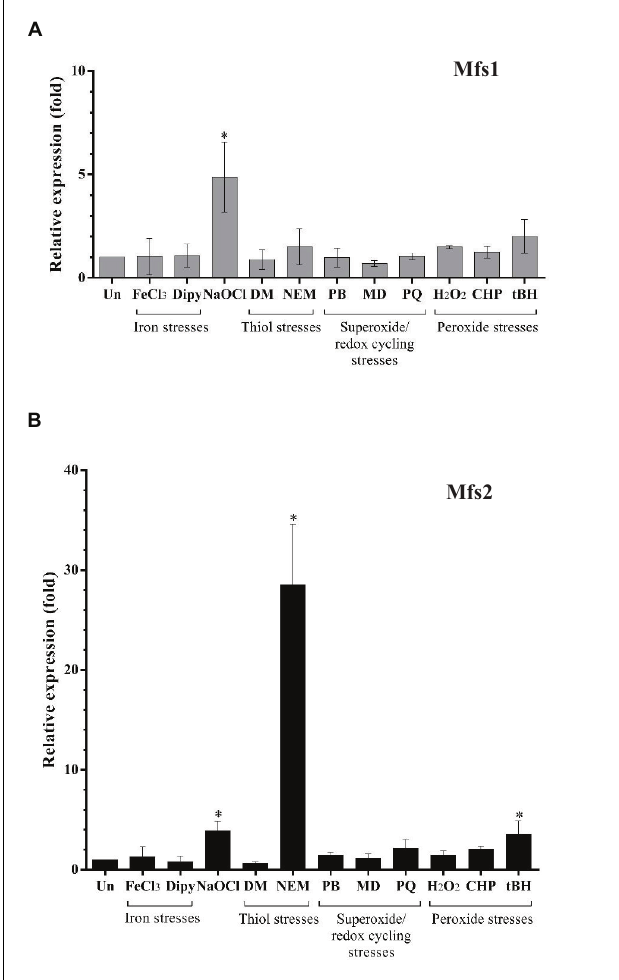
FIGURE 1 | Relative expression of (A) mfs1 and (B) mfs2 in response to stresses in PAO1 wild-type, determined by semi-quantitative real-time RT-PCR. Mid-log phase PAO1 wild-type cells were treated with 100 µ M of iron (FeCl 3 ), 100 µ M of iron depletion agent, 2,2 (cid:48) -Bipyridine (Dipy), 0.02% of NaOCl, 500 µ M of diamide (DM), 100 µ M of N-Ethylmaleimide (NEM), 250 µ M of plumbagin (PB), 1 mM of menadione (MD) 1 mM of paraquat (PQ), 1 mM of hydrogen peroxide (H 2 O 2 ), 500 µ M of cumene peroxide (CHP), and 500 µ M of t-butyl hydroperoxide (tBH) for 15 min. After normalizing data with internal control (16S rRNA), gene expression in each condition was compared to the untreated control (Un) and fold changes were calculated. Data presented are means ± SD of three biological replicates. Asterisk ( ∗ ) indicates significant difference relative to untreated (Un) ( p- value <